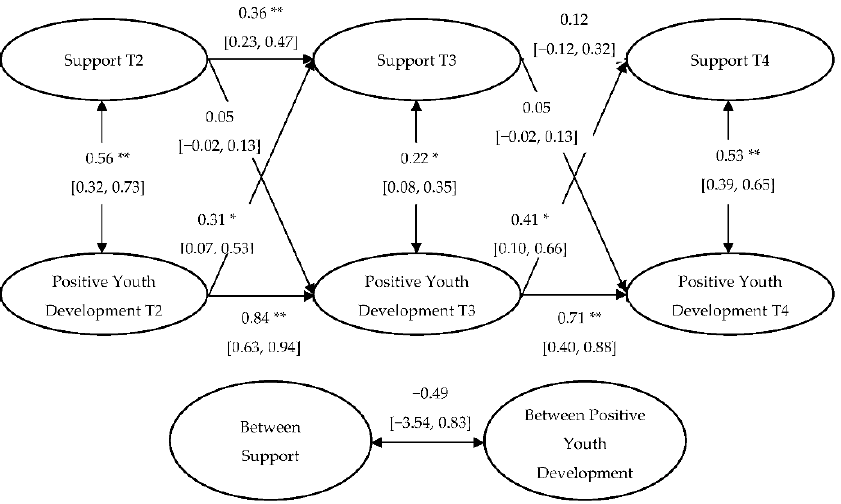
Figure 3. simplified random intercept cross ‐ lagged panel model between perceived support and Positive Youth Development with standardized coefficients. Note: Cross ‐ lagged paths are fixed to <